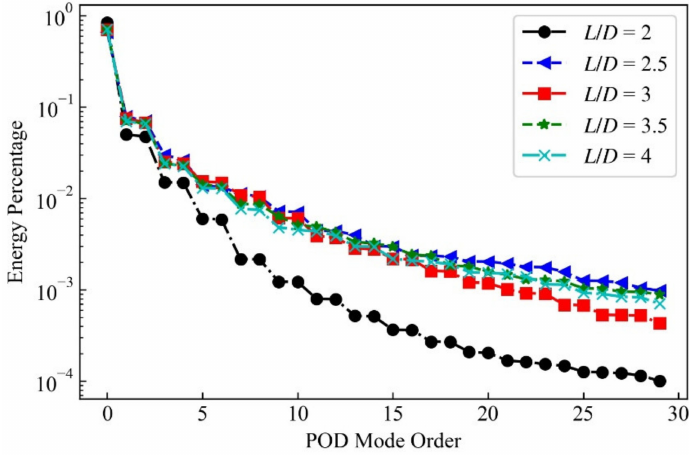
Figure 5. Energy distribution of the Proper Orthogonal Decomposition (POD)